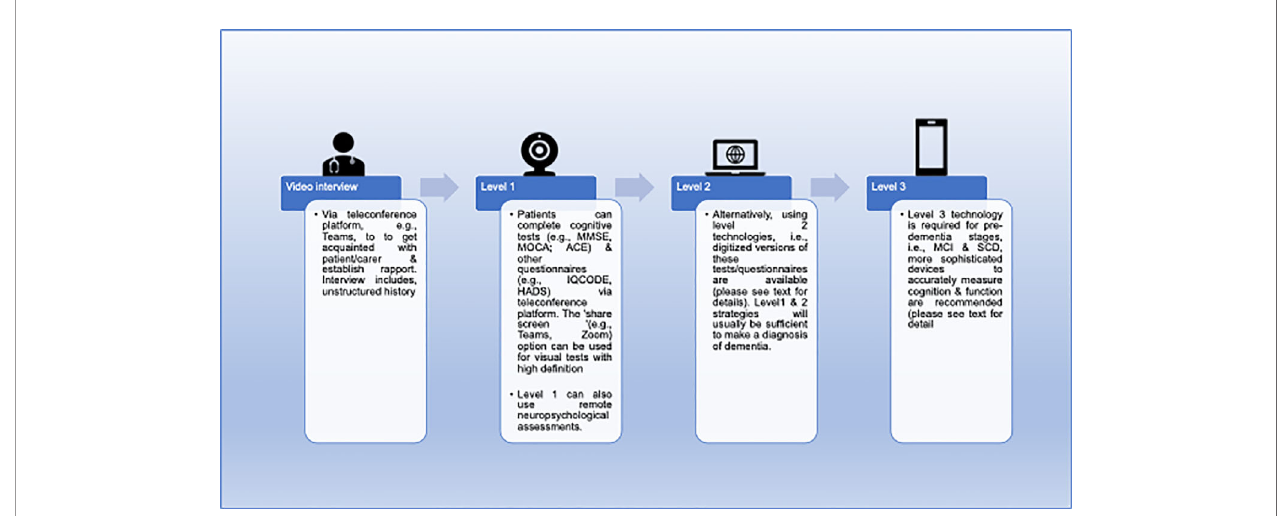
FIGURE 1 | Example of remote memory clinic care pathway. ACE, Addenbrooke ’ s cognitive examination; HADS, Hospital Anxiety and Depression Scale, IQCODE, Informant Questionnaire on Cognitive Decline in the Elderly; MCI, mild cognitive impairment; MMSE, Mini Mental State Exam; MoCA, Montreal Cognitive Assessment; SCD, subjective cognitive